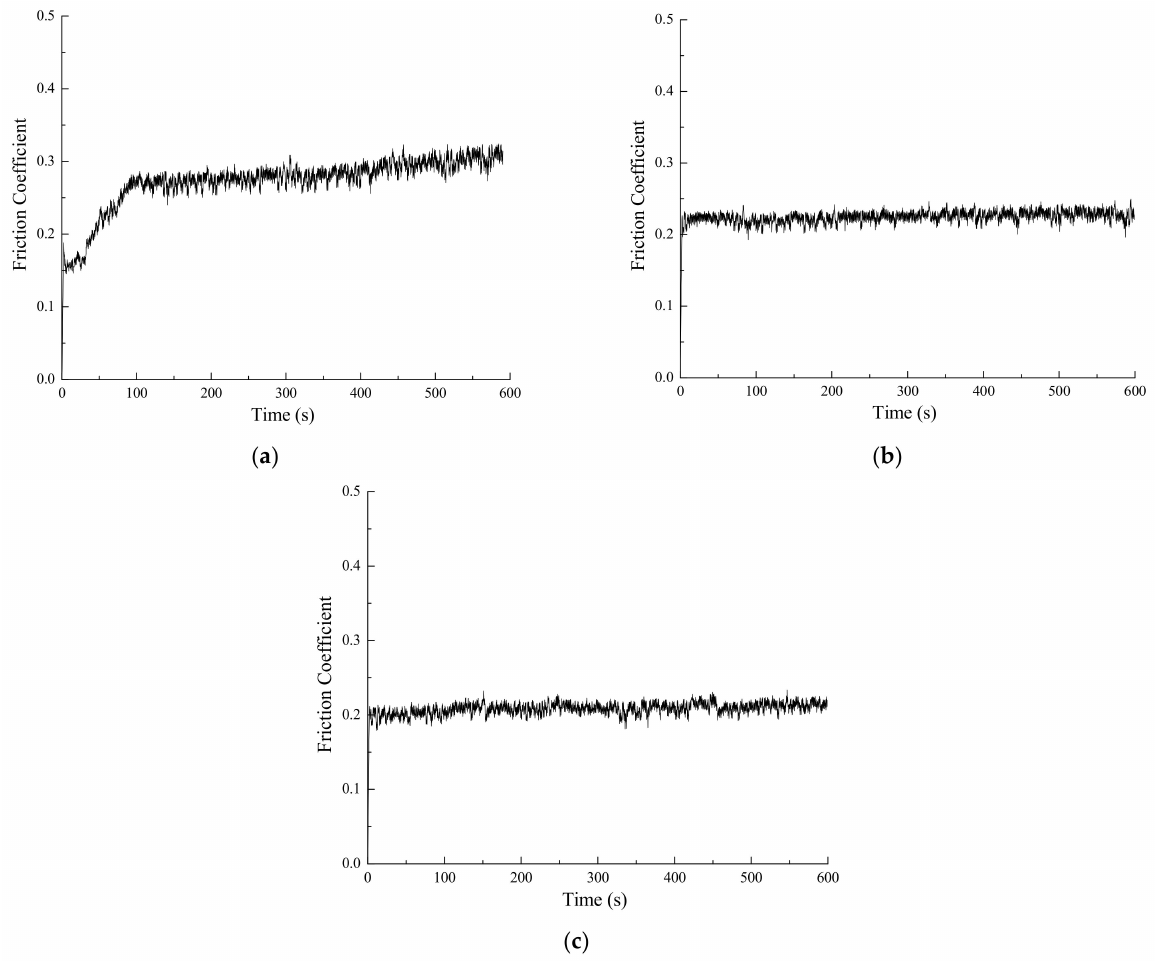
Figure 6. Friction coefficient variation during the running-in coating tests of specimen 2: ( a ) loads of 5 N; ( b ) loads of 10 N; ( c ) loads of 15